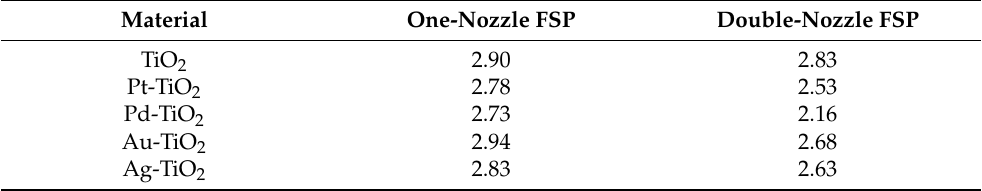
Table 2. Band-gap values of (Eg) of nanocatalysts 0.5% NM 0 /TiO 2 (One and Double-Nozzle FSP). Material One-Nozzle